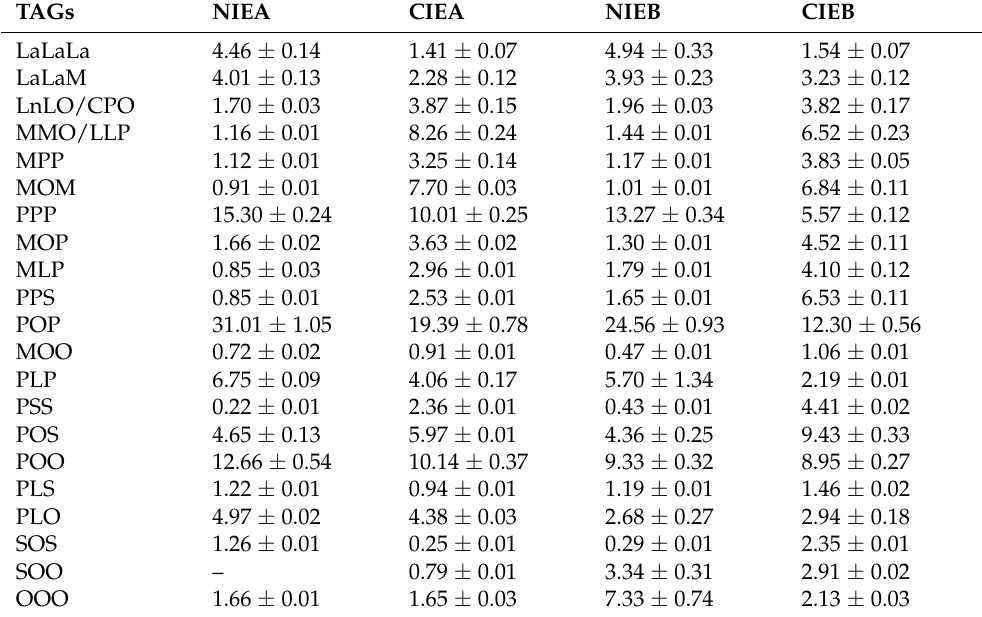
Table 3. TAG composition(wt.%) of two different formulations before and after CIE.